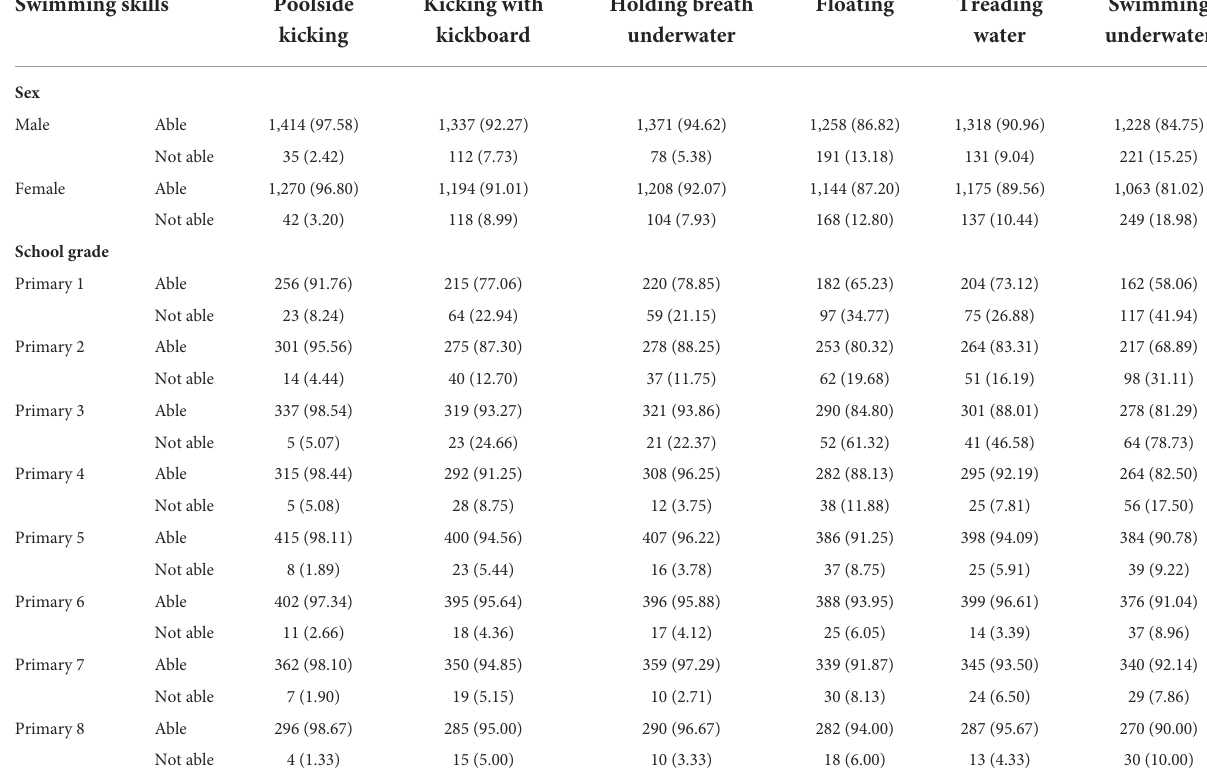
TABLE 3 Swimming skills by sex and school grade. Swimming skills